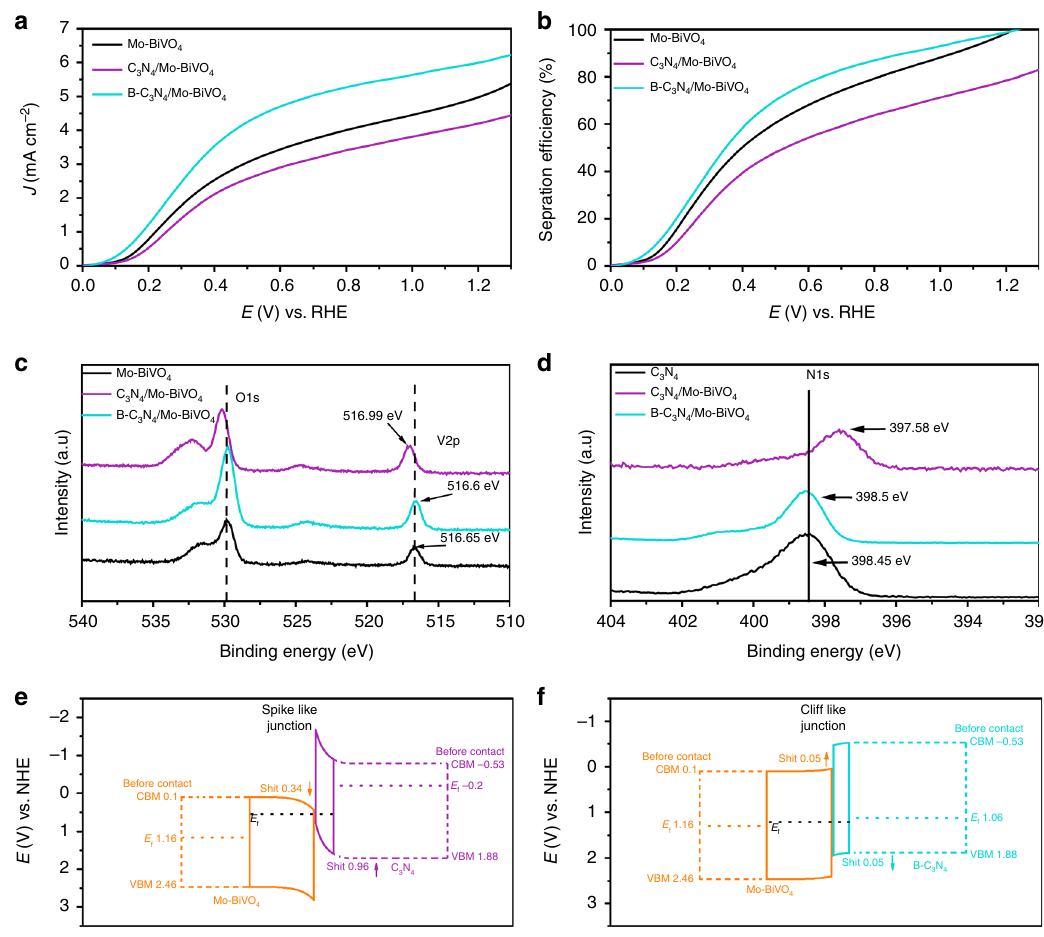
Fig. 3 Photoelectrochemical performances and charge transfer processes. a LSV curves of C 3 N 4 /Mo-BiVO 4 , 0.1% Mo-BiVO 4 and B-C 3 N 4 /Mo-BiVO 4 measured at a scan rate of 25 mV s − 1 under AM 1.5 G irradiation in PPB solution with Na 2 SO 3 as a hole scavenger (pH 7). b Separation ef fi ciency ( Φ Sep ) of C 3 N 4 /Mo-BiVO 4 , 0.1% Mo-BiVO 4 and B-C 3 N 4 /Mo-BiVO 4 . XPS core-level shifts of c V 2p, O 1 s and d N 1 s. Schematic diagrams of the band structures of e C 3 N 4 /Mo-BiVO 4 , f B-C 3 N 4 /Mo-BiVO con fi rms that the Fermi energy level of Mo-BiVO 4 and B-C 3 N 4 changed after Mo and B element doping (Supplementary Fig. 14).